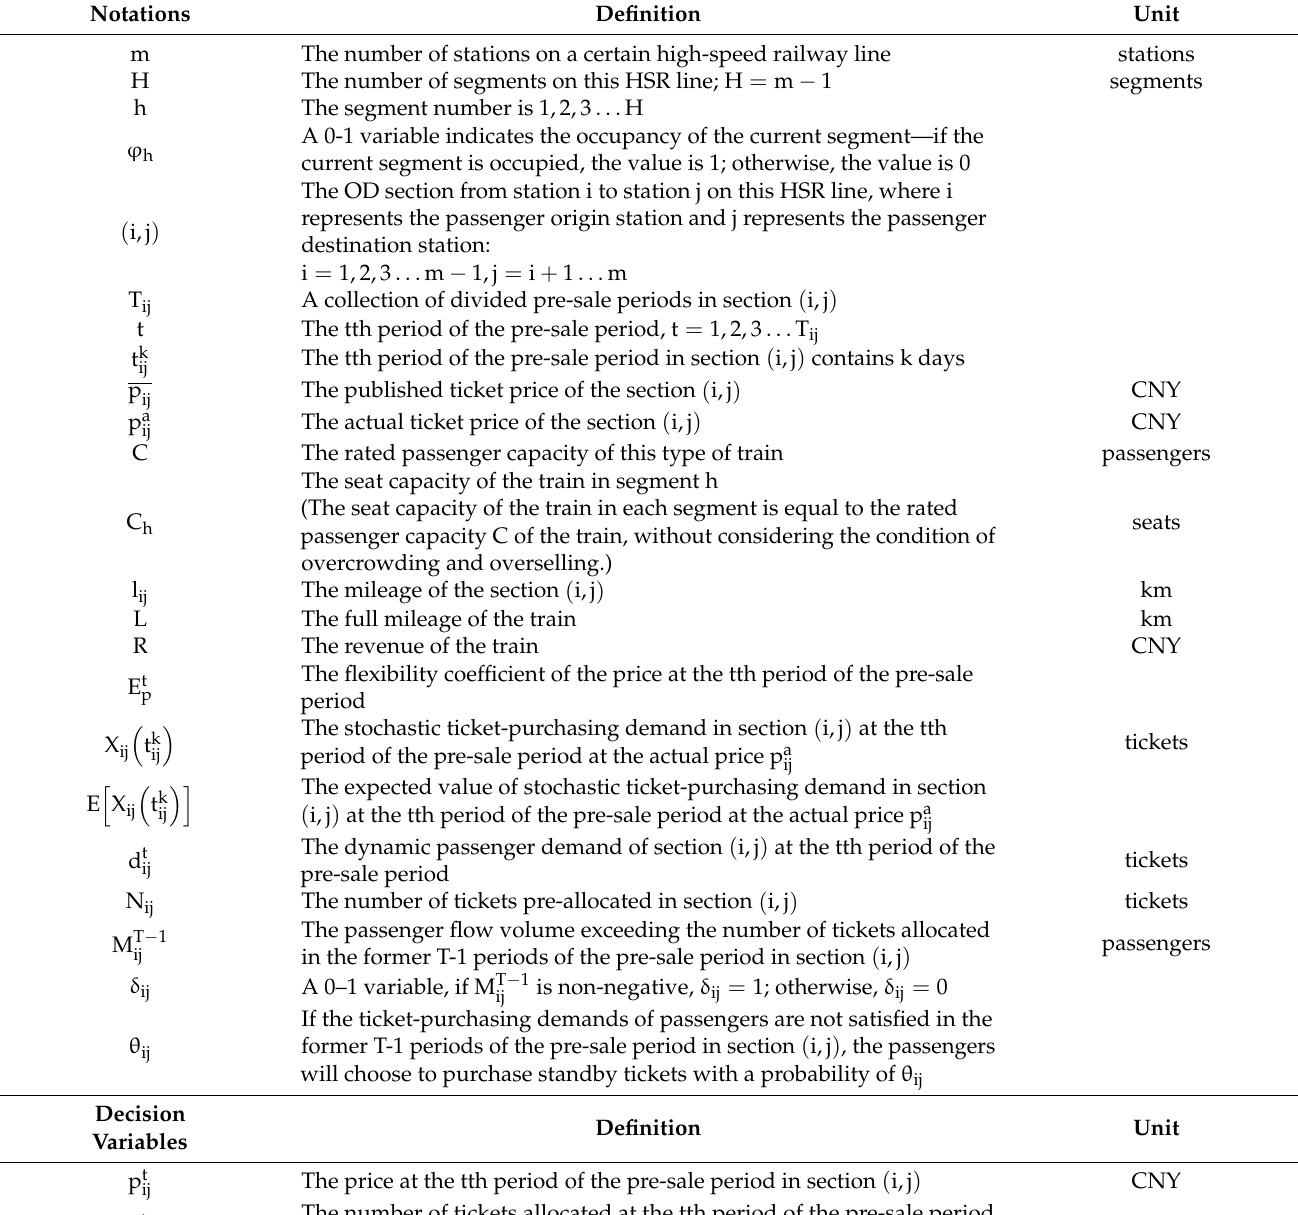
Table 1. Notations in this